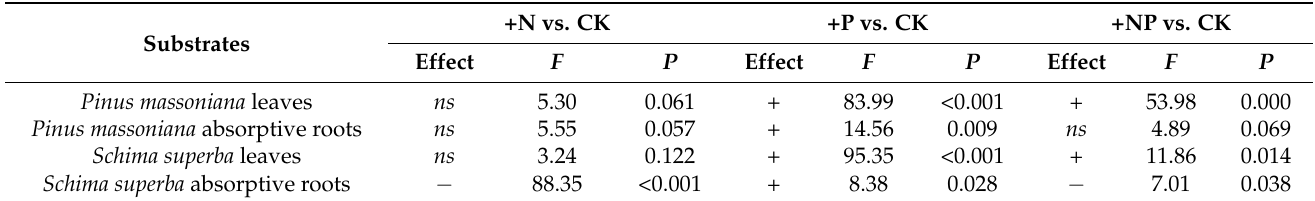
Table 3. Results ( p -values) showing the effects of nutrient addition on the 3-year decomposition of leaves and absorptive roots of Pinus massoniana and Schima superba .